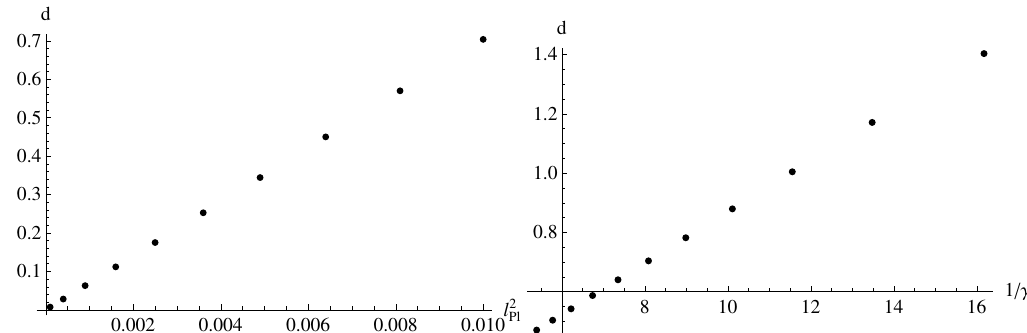
Figure 7. Left : By varying l Pl , one can calculate d ∝ l 2 l Pl = 0.1), one can see a linear dependence d ∝ 1/ γ . We can numerically conclude that d (cid:39) 8.7 × l 2